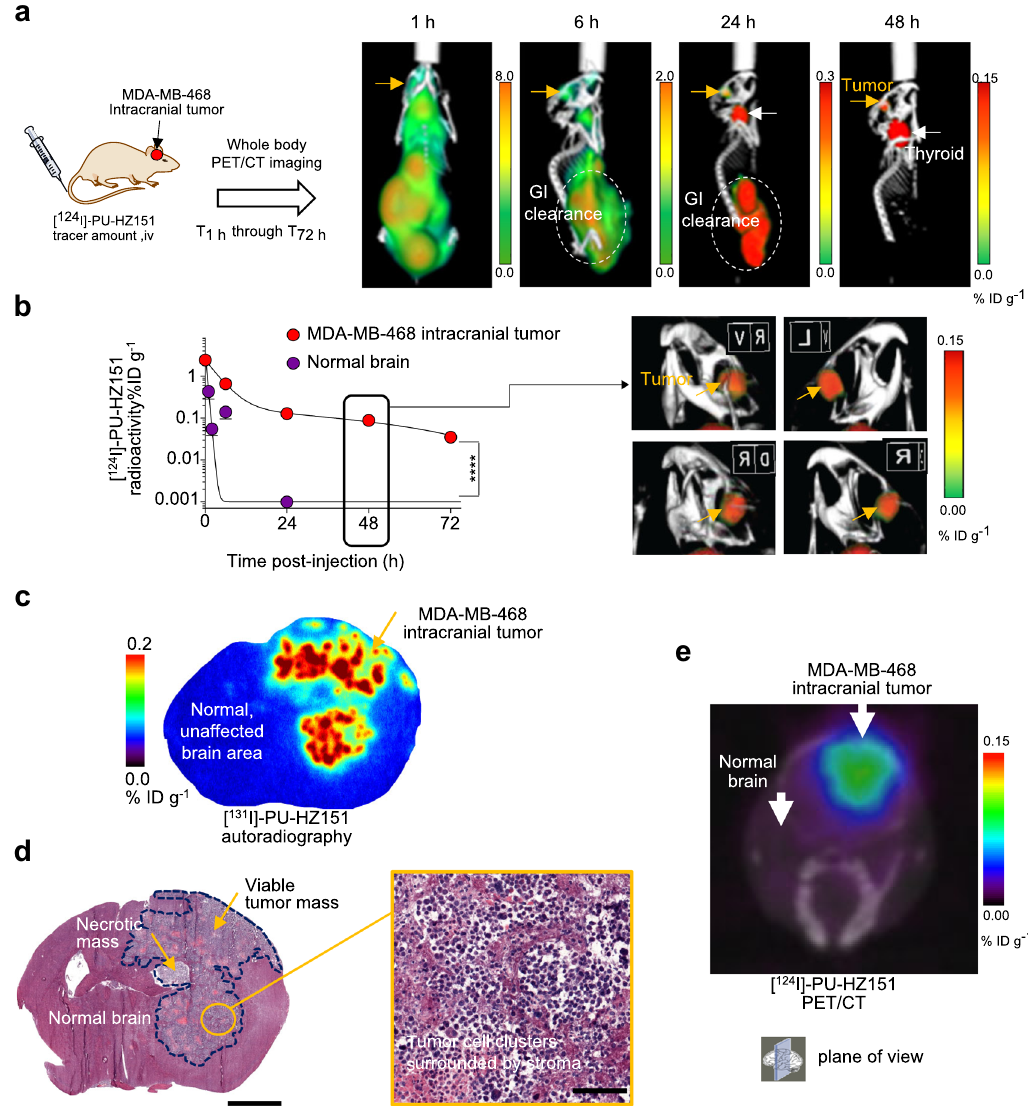
Fig. 4 Radiolabeled PU-HZ151 detects epichaperome-positive lesions of the CNS. a Experimental design to detect through PET imaging epichaperome- positive CNS lesions. Representative whole-body serial PET/CT images of mice as in b are also shown. b PET determined time-dependent concentration of [ 124 I]-PU-HZ151 in intracranial epichaperome + ve (MDA-MB-468) tumors and in the surrounding, unaffected brain. Serial PET/CT images were obtained at the times indicated after single intravenous infusion of a microdose of [ 124 I]-PU-HZ151 (15 µ Ci g − 1 ). PET/CT image of representative mice obtained